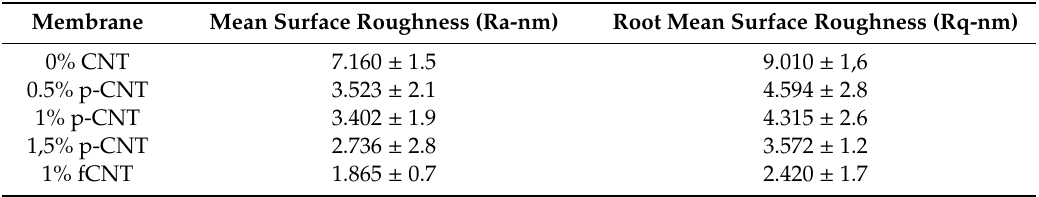
Table 2. E ff ect of CNT loading on membrane